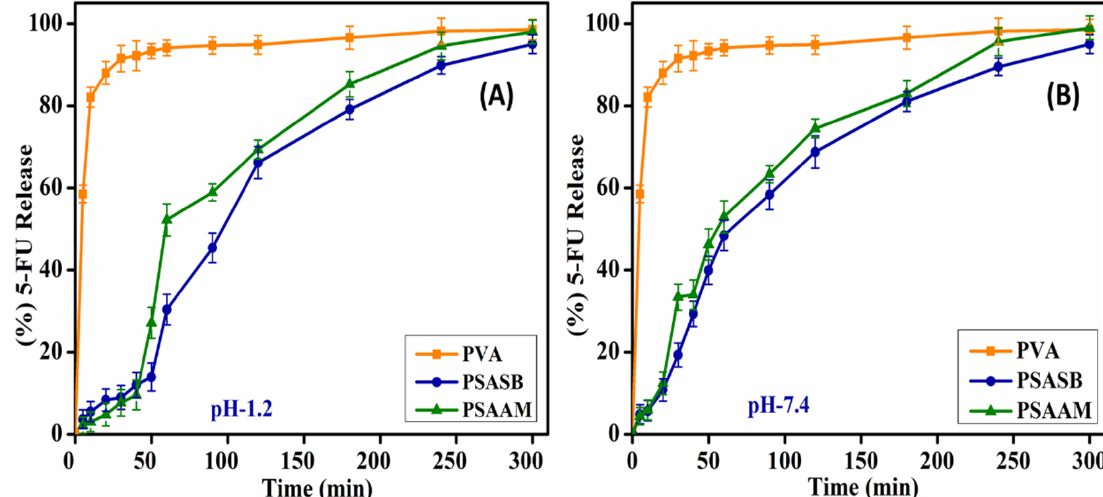
Figure 5. FU release characteristics of PVA, PSASB and PSAAM in pH 1.2 ( A ) and 7.4 ( B ) at 37 °C.